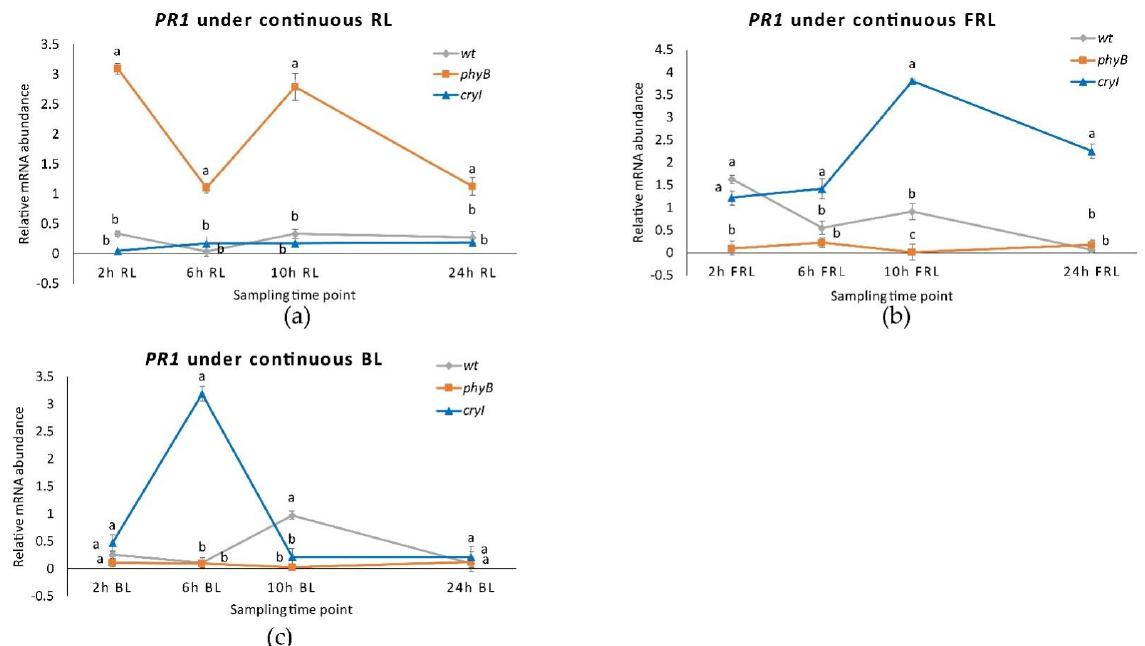
Figure 10. PR1 expression in plantlets of Dar Gazi-wt , Dar Gazi-phyB , and Dar Gazi-cry1 : ( a ) in 24 h continuous RL, panel; ( b ) in 24 h continuous FRL, panel; ( c ) in 24 h continuous BL, panel. Results are presented after normalization with ef1A . Data shown are the average of two biological replicates run in triplicate, with error bars representing SD. At each time point values with different letters significantly differ according to the analysis of the variance (ANOVA) and least significant difference (LSD) tests ( p ≤ 0.05).